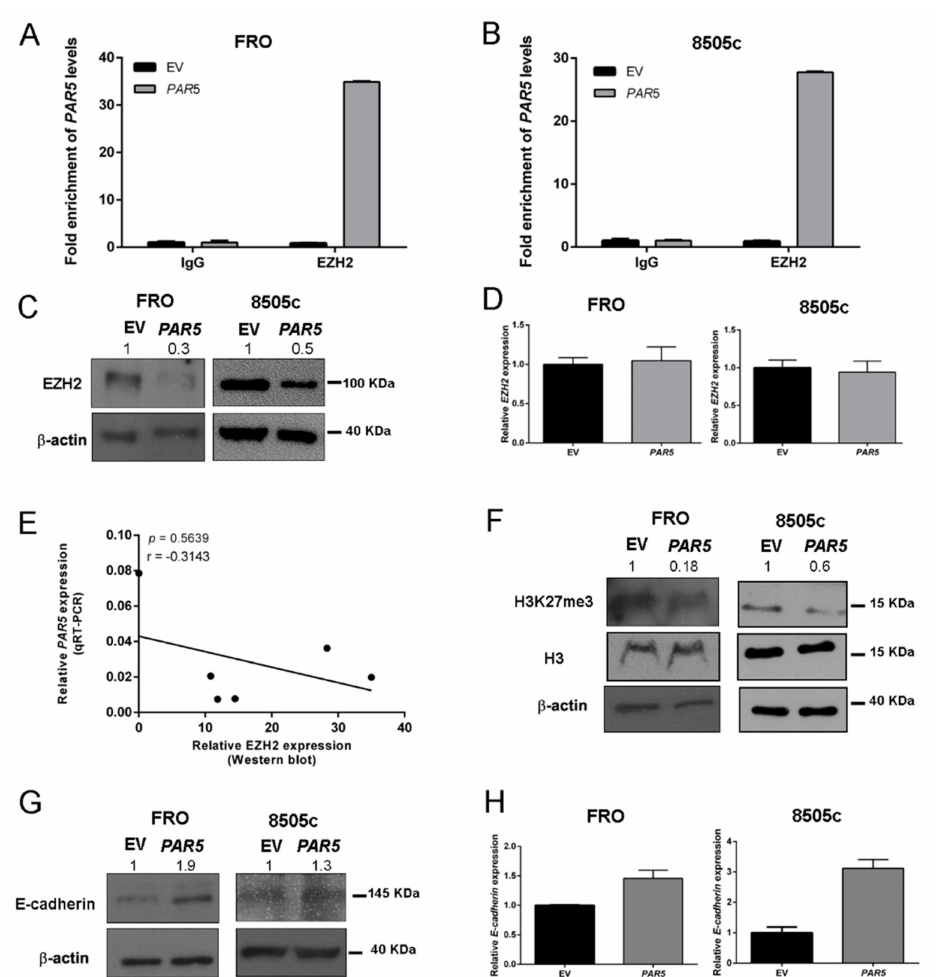
Figure 5. PAR5 interacts with Enhancer of Zeste Homolog 2 (EZH2) modulating E-cadherin expression. ( A , B ) RNA immunoprecipitation (RIP) assay was performed on extracts obtained from FRO and 8505c cells transfected with pCMV- PAR5 or the EV, using an anti-EZH2 antibody or a pre-immune (IgG) serum, as control. qRT-PCR was performed on the samples to assess fold enrichment of PAR5 precipitated by the anti-EZH2 antibody relative to IgG control, set equal to 1. ( C ) Western blot analysis of EZH2 expression in FRO and 8505c stably expressing PAR5 or carrying the corresponding EV. β -actin was used to normalize the amount of loaded protein. Densitometric analysis was performed by using ImageJ software to analyse protein expression compared to the EV, set equal to 1. ( D ) qRT-PCR analysis to evaluate the expression of EZH2 after PAR5 transfection. Data were reported as relative expression ± SD and were compared to the EV, set equal to 1. ( E ) Correlation scatter plot (Spearman’s Rank) between qRT-PCR levels of PAR5 and Western blot levels of EZH2 analyzed in six ATC samples ( r = − 0.3143; p = 0.5639). ( F , G ) Western blot analysis of H3K27me3 and E-cadherin expression in FRO and 8505c stably expressing PAR5 or carrying the corresponding EV. H3 and β -actin were used to normalize the amount of loaded protein. Densitometric analysis was performed by using ImageJ software to analyze protein expression compared to the EV, set equal to 1. ( H ) qRT-PCR analysis to evaluate the expression of E-cadherin after PAR5 transfection. Data were reported as relative expression ± SD and compared to the EV, set equal to